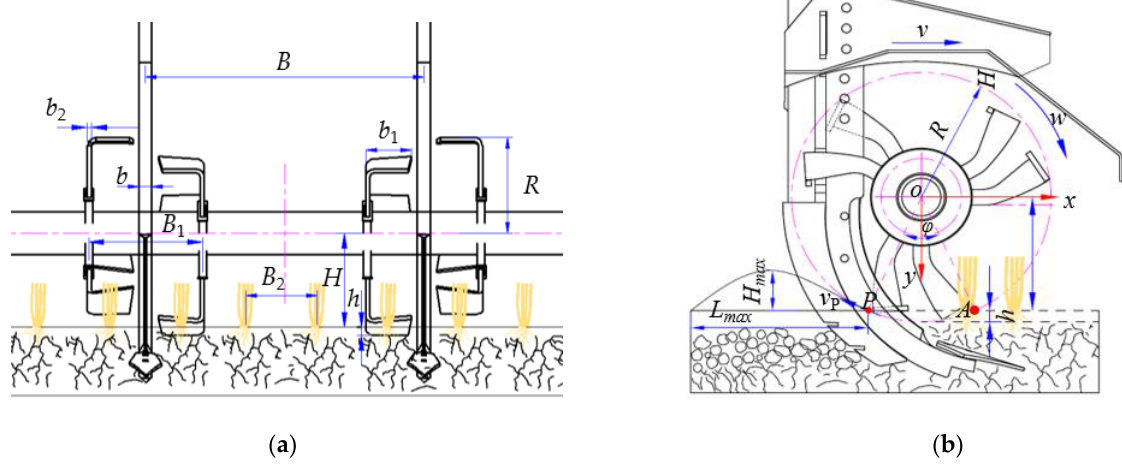
Figure 3. The working mechanism and parameter design of straw crushing and throwing. ( a ) Relative position of the opposite-placed anti-blocking mechanism; ( b ) Working principle diagram of the anti-blocking device.